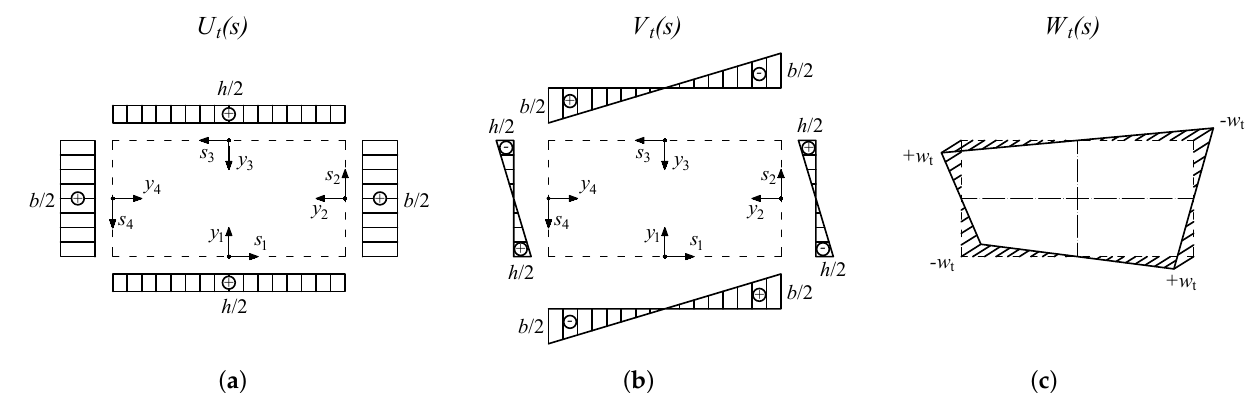
Figure 3. Torsional mode: ( a ) tangential displacements, ( b ) normal displacements, and ( c )